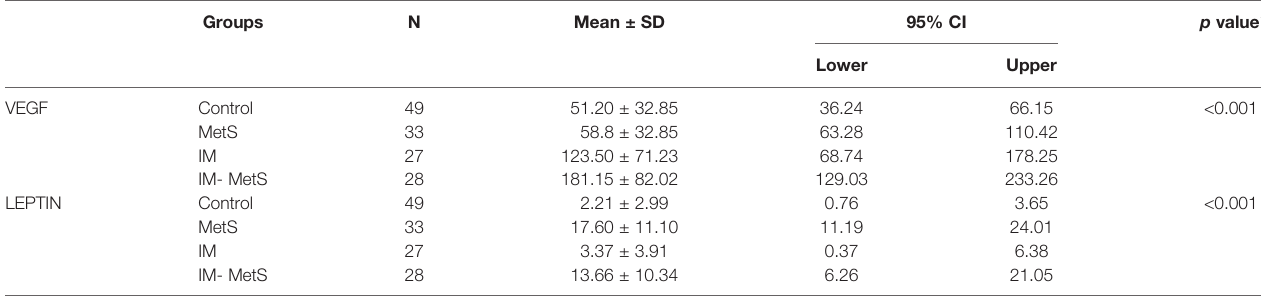
TABLE 3 | Analysis of VEGF and Leptin values between the groups.